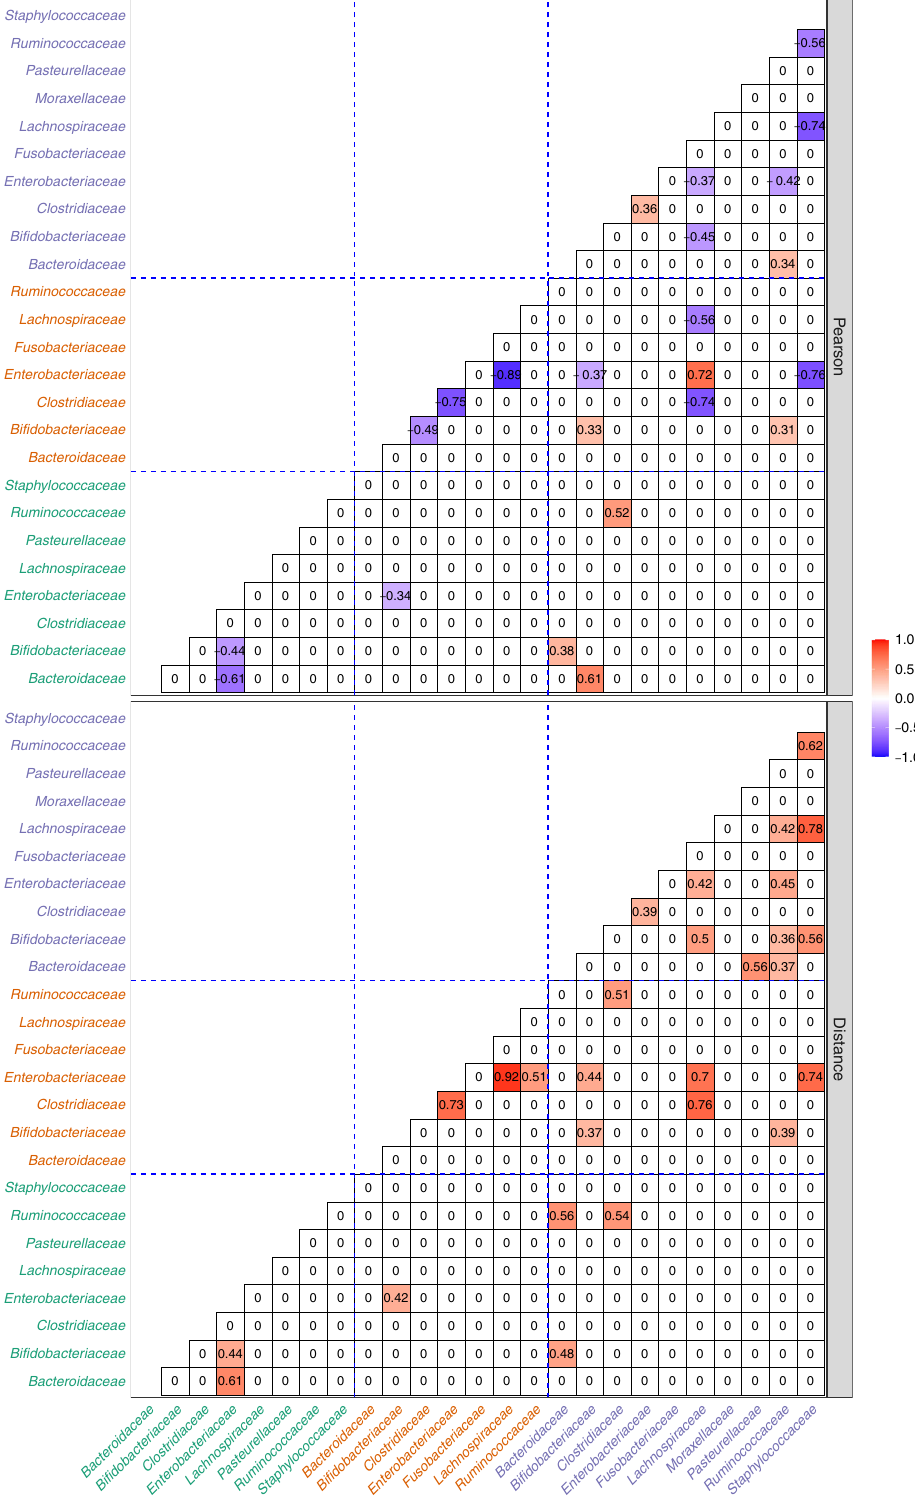
separate families between different time points. The top ten most abundant families up to 365 days were selected for the visualization purpose. Families with prevalenceacrosssamples<10%werediscarded.Thecorrelationcoef fi cientranges from − 1 to 1, color-coded by blue to red,